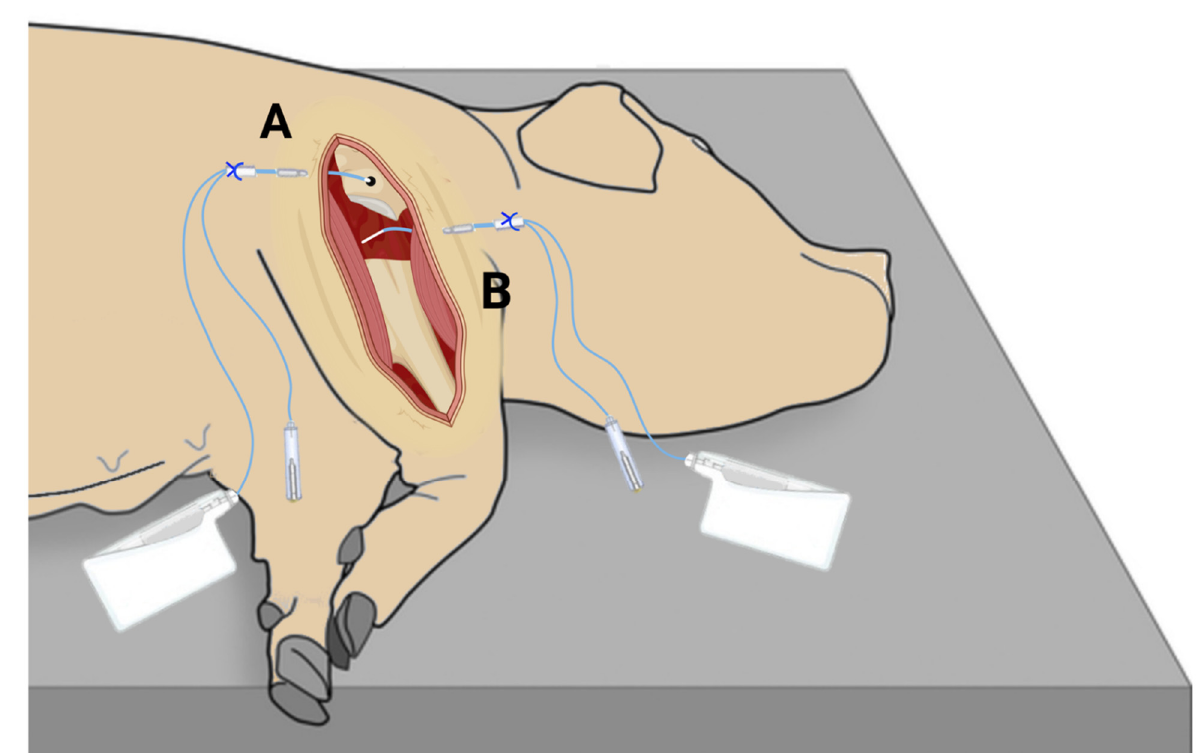
Figure 2. Illustration of the placement of microdialysis catheters. ( A ) cancellous bone of scapular neck; ( B ) deadspace. Figure 2 was created with BioRender.com [42].